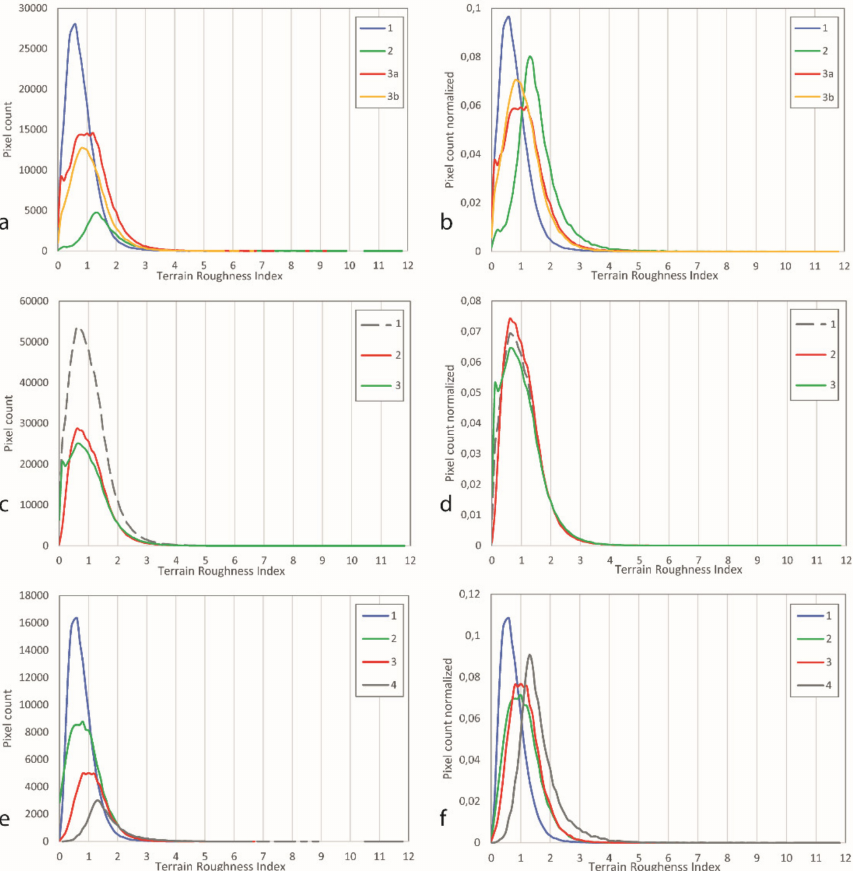
Figure 9. Trends of TRI variable: ( a ) in the sectors subdividing the study area: Pesaro–Punta degli Schiavi (1), Punta degli Schiavi–Mt. Brisighella (2), Mt. Brisighella–Castel di Mezzo (3a), and Castel di Mezzo–Vallugola (3b); ( b ) in the sectors subdividing the study area considering normalized values: Pesaro–Punta degli Schiavi (1), Punta degli Schiavi–Mt. Brisighella (2), Mt. Brisighella–Castel di Mezzo (3a), and Castel di Mezzo–Vallugola (3b); ( c ) in the total study area (1) in comparison with areas affected (2) or not affected (3) by landslides; ( d ) in the total study area (1) in comparison with areas affected (2) or not affected (3) by landslides considering normalized values; ( e ) for each landslide typology occurring in the study area: slides (1), slumps (2), flows (3), and diffuse instability (4); ( f ) for each landslide typology occurring in the study area considering normalized values: slides (1), slumps (2), flows (3), and diffuse instability